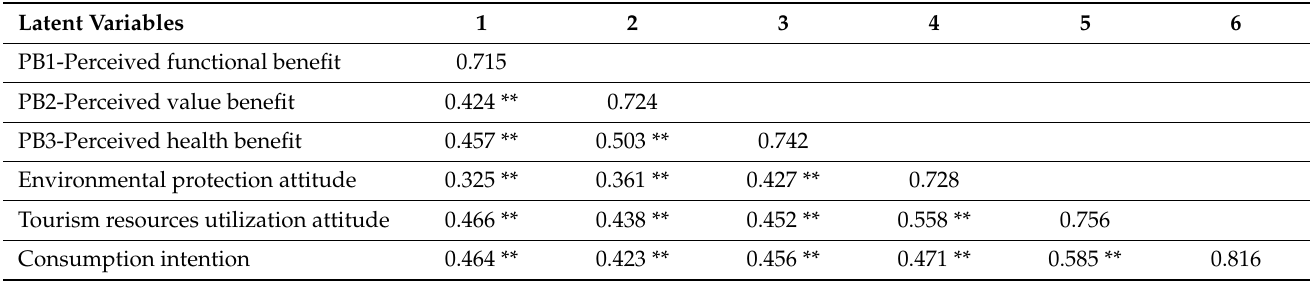
Table 2. Results of convergence and discriminative validity test.